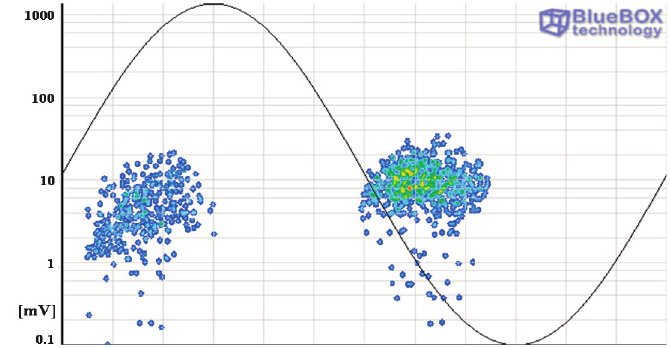
Figure 28. ( a ) PD pulse measured with the sensor UHF 1 and converted into a HF pulse; ( b ) PD pulse measured with the sensor UHF 2 and converted into a HF pulse.